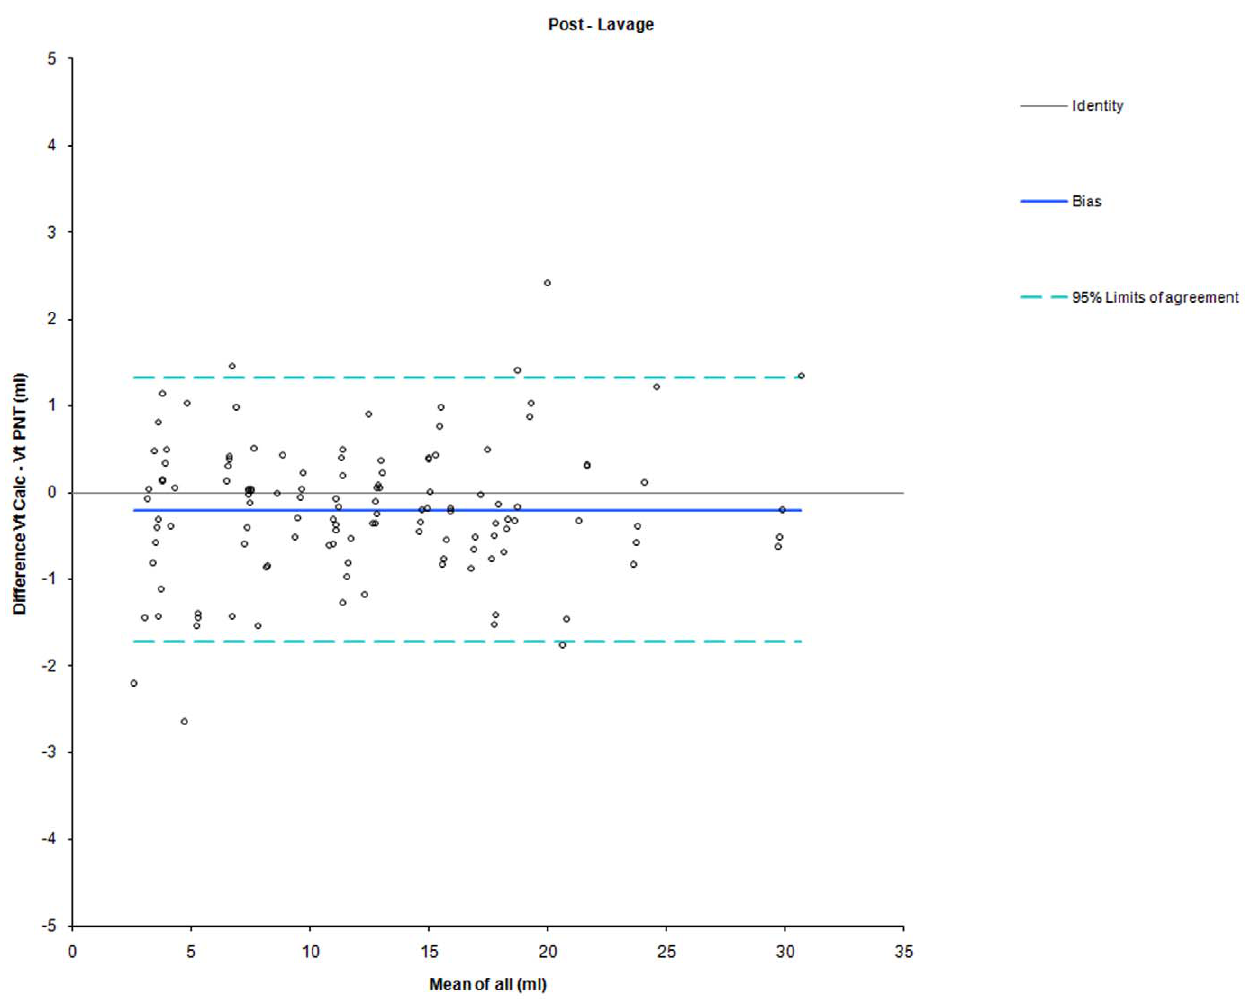
Figure 5. Bland-Altman Plot for comparison between VT calc and VT PNT during post-lavage measurements. Shown are Line of Identity (grey line), Bias (blue line), and 95%-Limits of Agreement (dashed line). Calibration was performed at each PEEP level in all animals. Data points indicate the means of measurements in individual piglets at different PEEP levels.